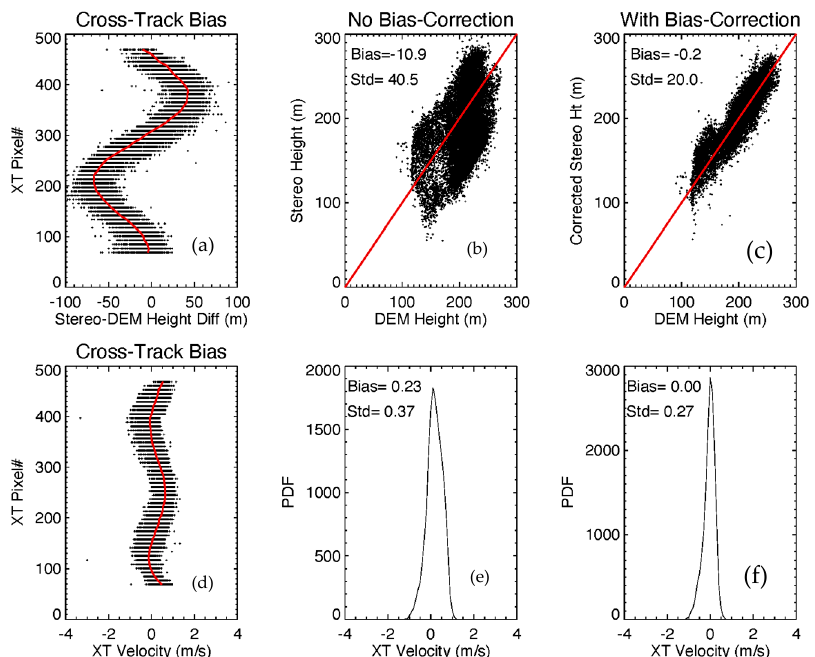
Figure 11. Statistical comparisons for ( a ) stereo-DEM height difference vs. XT pixel; ( b ) DEM height vs. uncorrected stereo height; ( c ) DEM height vs. corrected stereo height; ( d ) XT velocity vs. XT pixel; ( e ) uncorrected XT velocity vs. probability distribution function (PDF); ( f ) corrected XT velocity vs. PDF.